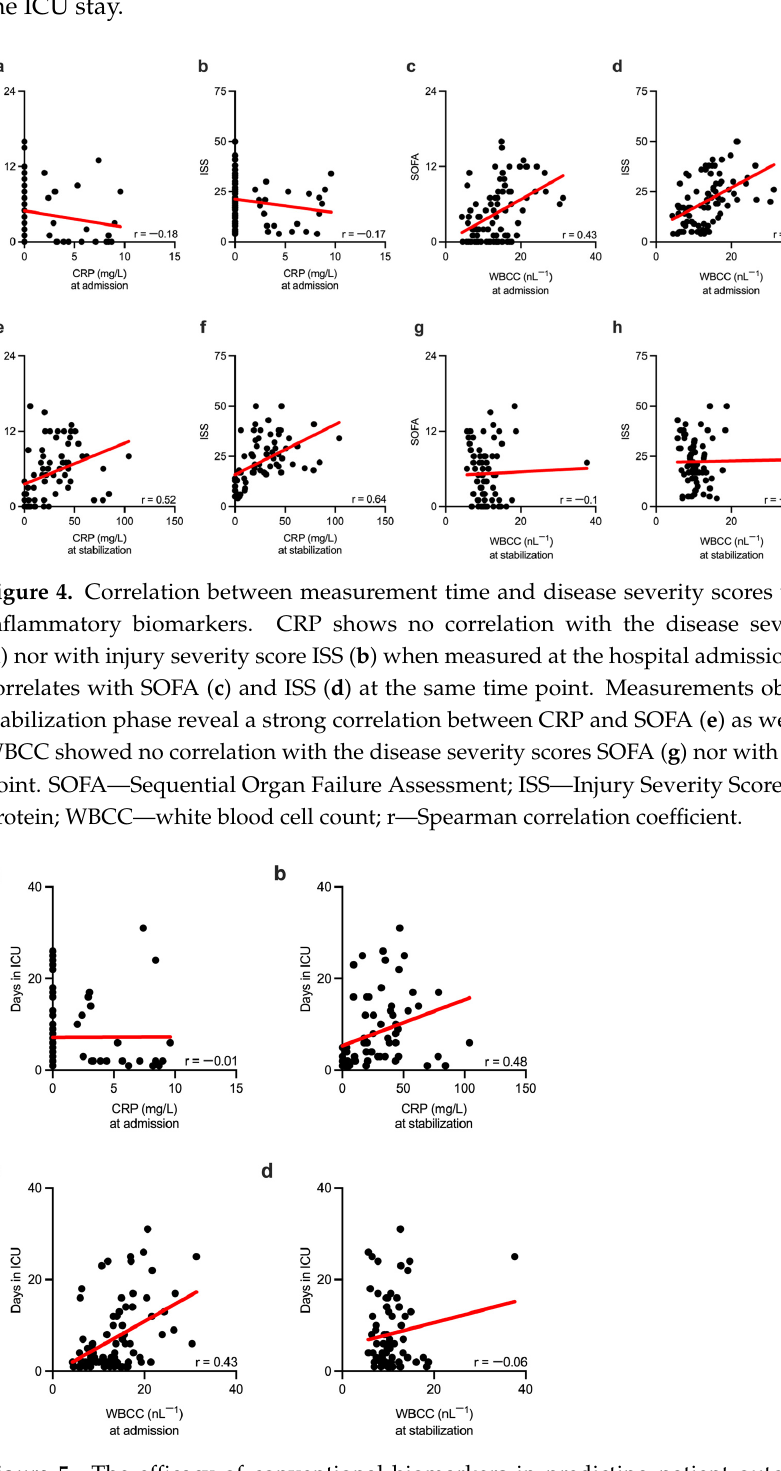
Figure 5. The efficacy of conventional biomarkers in predicting patient outcomes depends on measurement time. Scatter plots show no correlation between length of ICU stay and CRP activity measured in injured patients at hospital admission. ( a ) CRP measured during the stabilization phase (secondary survey) strongly correlated with the length of the ICU stay in these patients ( b ) WBCC obtained at admission correlated well with the length of the ICU stay ( c ) WBCC obtained during the stabilization phase failed to correlate with the length of ICU stay ( d ) ICU—intensive care unit; CRP—C-reactive protein; WBCC—white blood cell count; r—Spearman correlation coefficient.